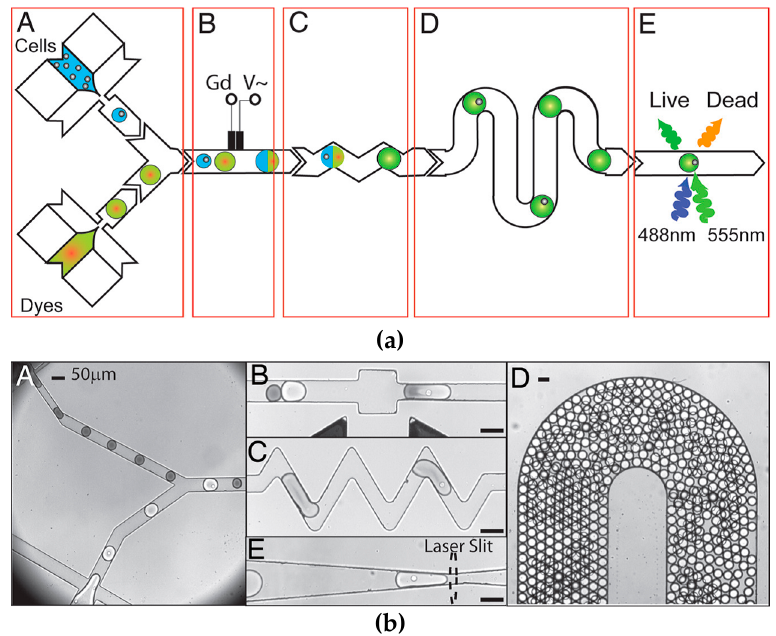
Figure 4. Schematic diagram and microscope images of viability assay by droplet generation reprinted with permission from Brouzes et al. Proc. Natl. Acad. Sci. USA., 106(34) (2009) Brouzes, Medkova [58], showing droplet fusion and reagent mixing, as well as high-throughput generation of cell-containing droplets. ( a - A ) Combination of cells and dyes, ( a - B ) in-line electrochemical sensor, ( a - C ) droplet fusion channels, ( a - D ) serpentine mixing channels ( a - E ) fluorescence assay. ( b - A ) micrograph of droplets entering channel, ( b - B ) droplet fusion, ( b - C ) droplet mixing, ( b - D ) high-throughput droplet generation in channel, ( b - E ) location of fluorescent excitation. Scale bars = 50 µm.